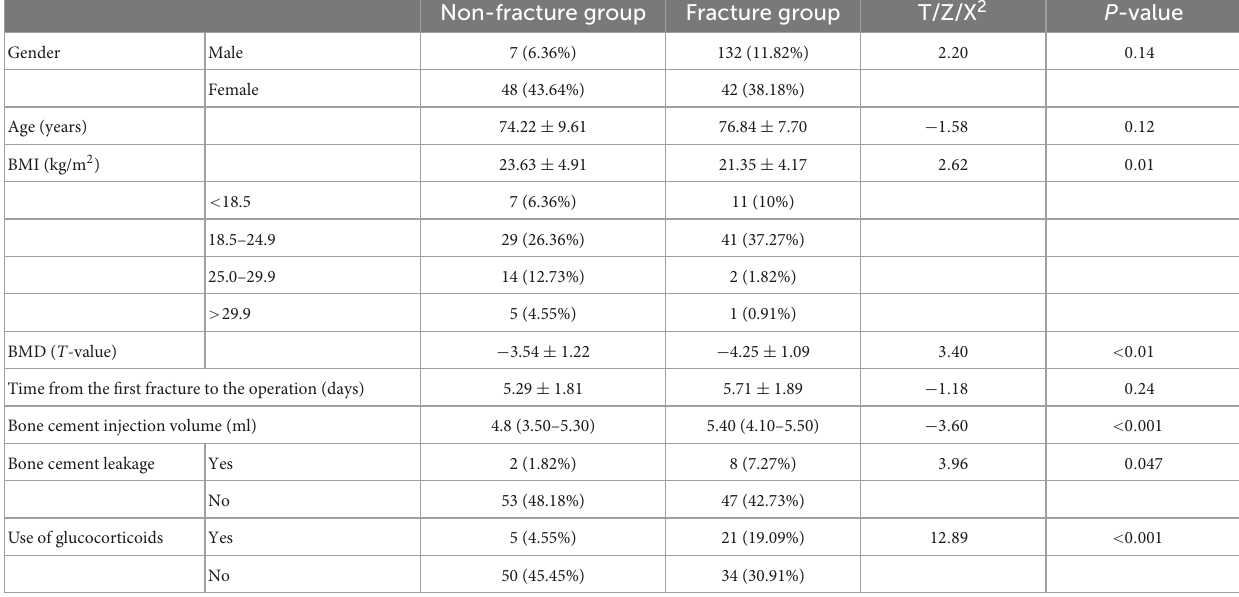
TABLE 1 Clinical baseline differences among participants.